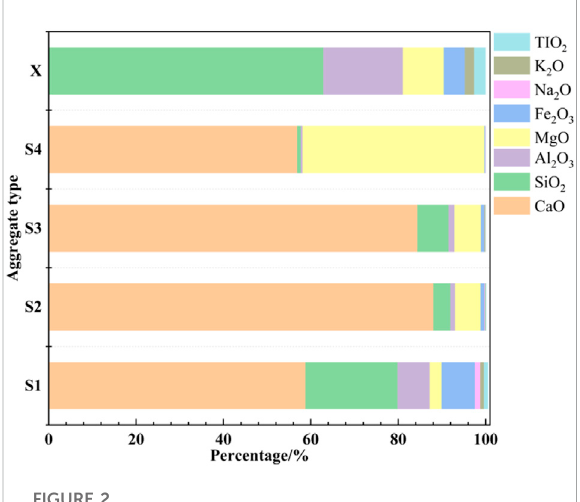
FIGURE 2 Main chemical composition of